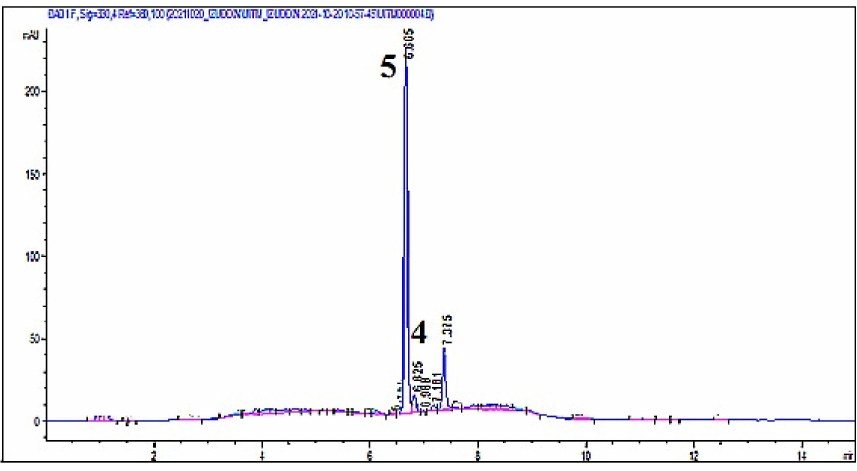
Figure 1. HPLC chromatogram of cold maceration ethanol extract